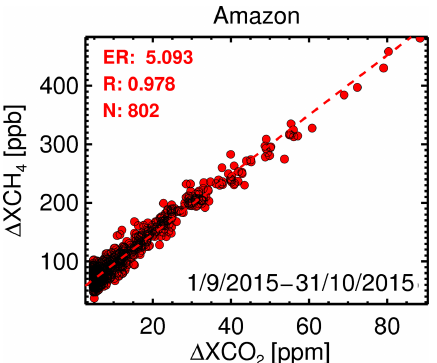
Figure B2. Scatterplot showing the (cid:49) XCH 4 vs. (cid:49) XCO 2 values, calculated as the difference between the values in the fire-affected soundings to those in the background cases over the entire Amazonian region from 1 September to 31 October 2015. The CH 4 / CO 2 ER is calculated from the gradient of a linear fit to the data. This line of best fit is also shown, along with the correlation coefficient R and the number of soundings N